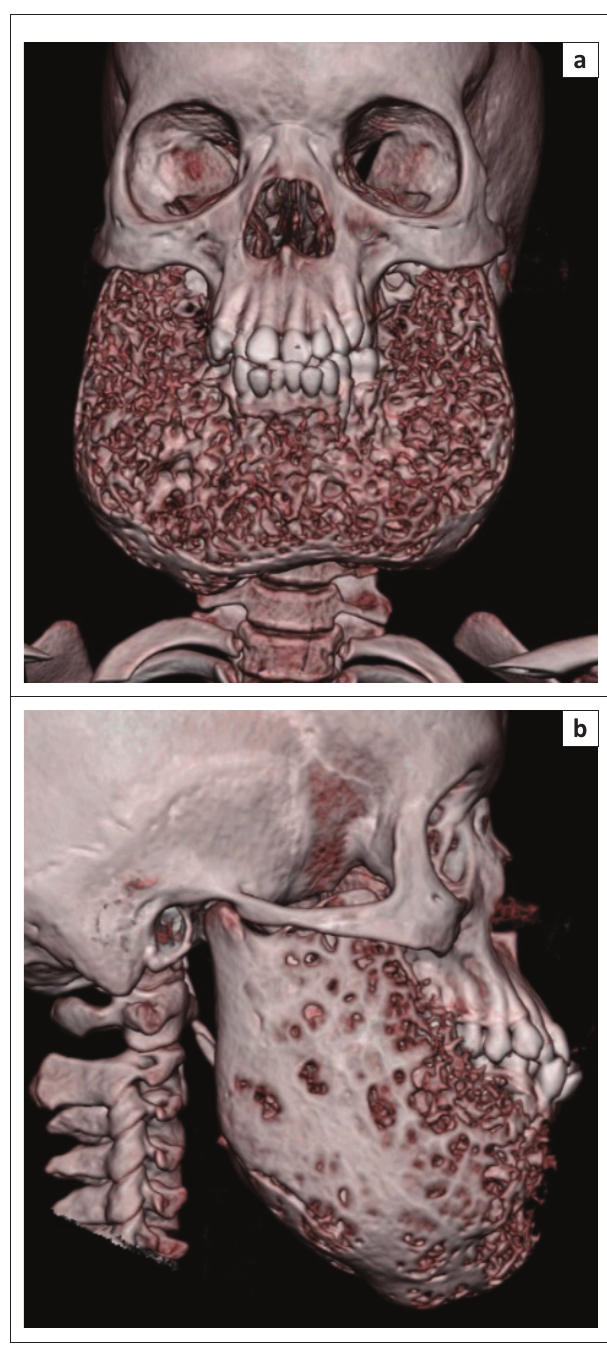
FIGURE 3: Frontal (a) and lateral (b) three-dimensional reconstructed computed tomography scans demonstrating diffuse, bilateral, expansile, multilocular lucencies in the mandible, with a soap-bubble appearance. Dental malposition is also demonstrated. The condylar heads of the mandible, temporomandibular joints and maxilla are not